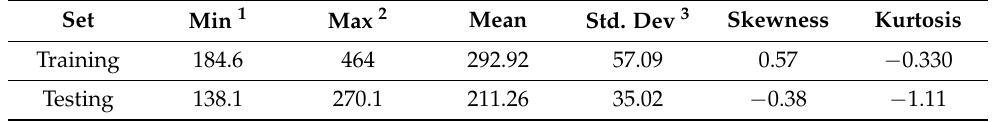
Table 1. Descriptive statistics for the great recession training and testing periods.